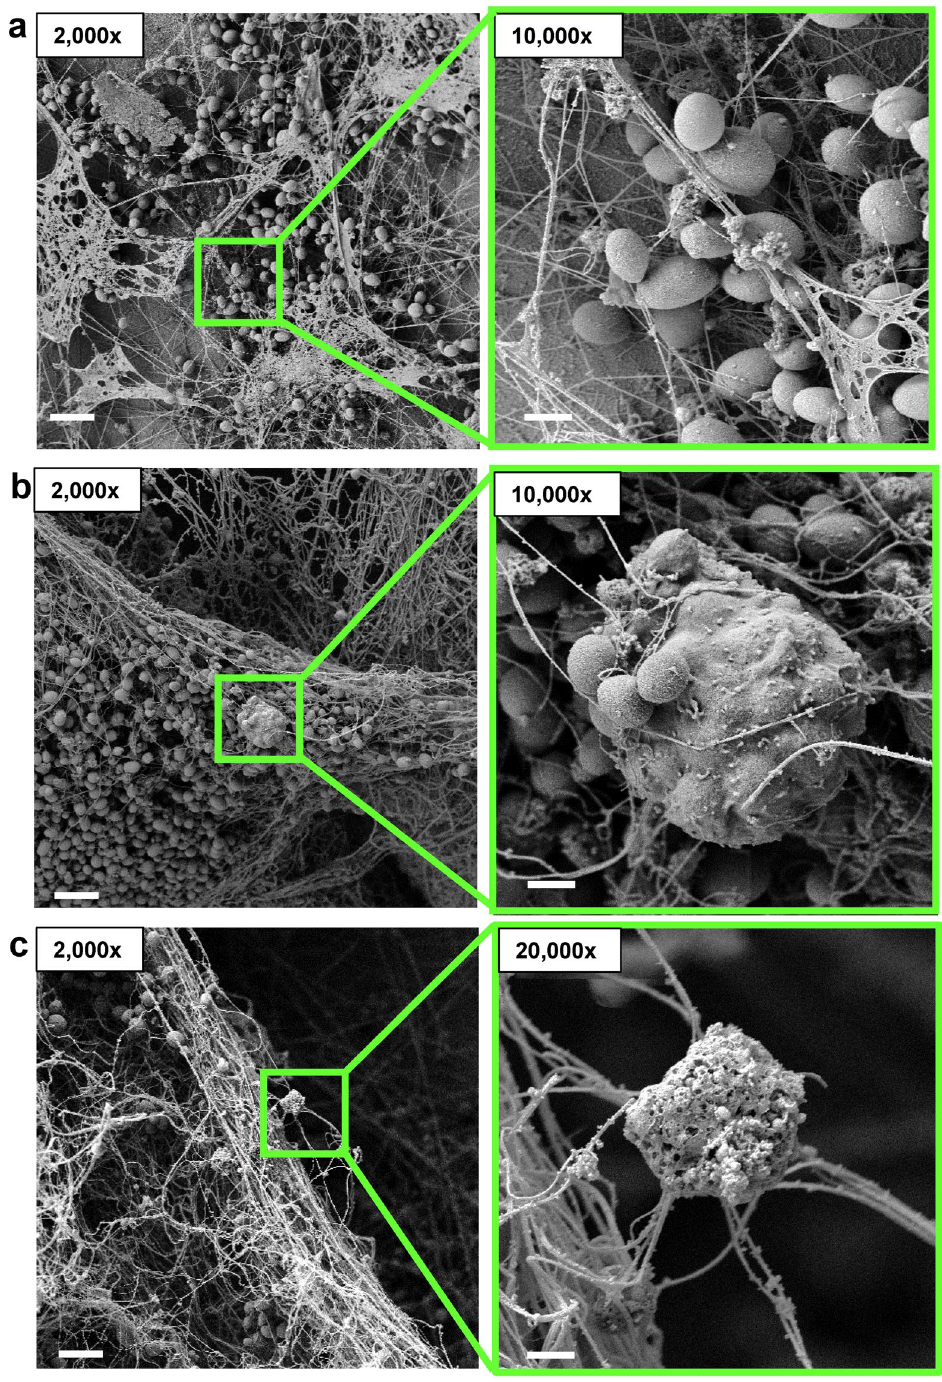
Figure 6. C . glabrata appears to induce the formation of NETs in vivo . ( a , b , c ) C . glabrata was inoculated in the lumen of rat jugular catheters. After 48 h, catheters were harvested and host-fungal interactions on the luminal catheter surface were observed by scanning electron microscopy. Measurement bars represent 10 µ m and 1 µ m for 2,000x and 10,000x images,